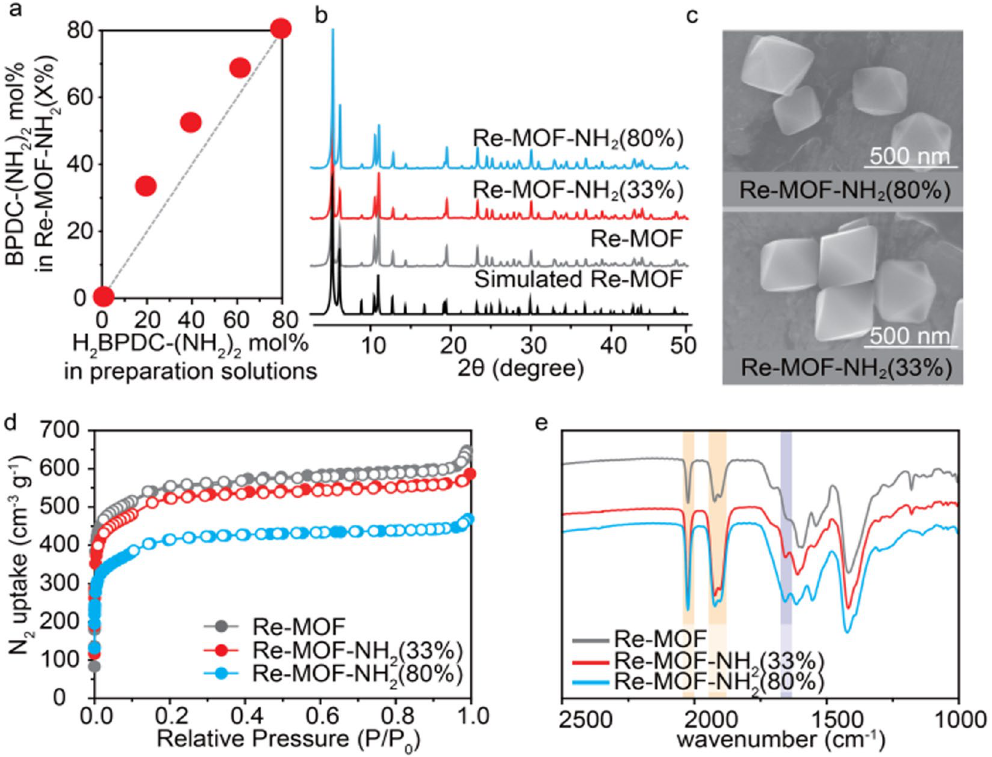
Figure 2. Structural analysis of Re-MOF-NH 2 (X%). ( a ) Percent incorporation of BPDC-(HN 2 ) 2 in Re- MOF-NH 2 (X%). ( b ) PXRD patterns of Re-MOF, Re-MOF-NH 2 (33%) and Re-MOF-NH 2 (80%) in comparison with the simulated pattern of Re-MOF. ( c ) SEM images of Re-MOF-NH 2 (33%) and Re-MOF-NH 2 (80%). ( d ) N 2 adsorption isotherms for Re-MOF, Re-MOF-NH 2 (33%) and Re-MOF-NH 2 (80%) at 77 K with adsorption and desorption points represented by closed circles and open circles, respectively ( P / P 0 , relative pressure). ( e ) IR spectra of Re-MOF, Re-MOF-NH 2 (33%) and Re-MOF-NH 2